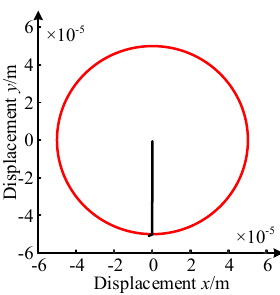
Figure 18. Axial trajectory under upper and lower unit failure. According to Figure 18, when both the upper and lower units fail, the rotor directly falls to the magnetic pole and collides with a little tremor.